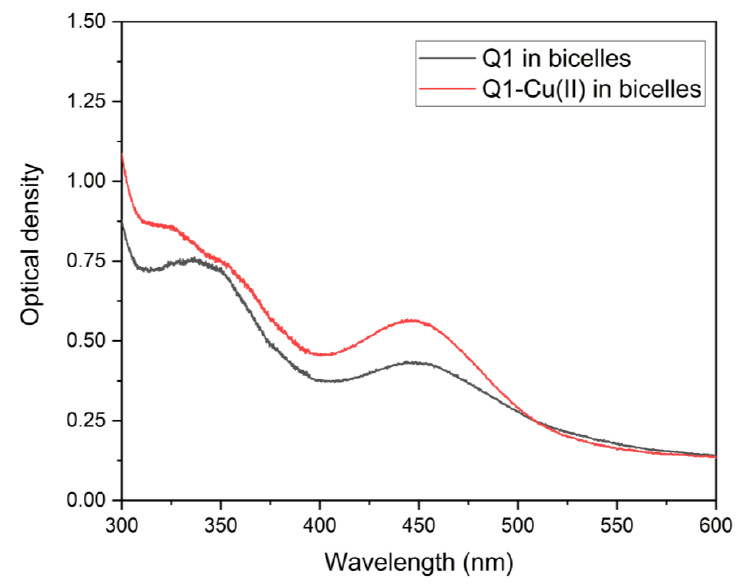
Figure 4. Optical absorption spectra of Q1 and the Q1 − Cu(II) complex in LA micelles. pH = 7.4. Q1 concentration was 0.02mM. CuCl 2 concentration was 0.01 mM.